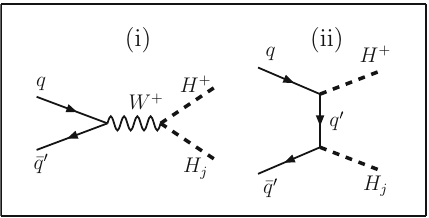
Fig. 9 Feynman diagrams for the production processes (6.4). If the line has no arrow, it represents either a quark or an antiquark